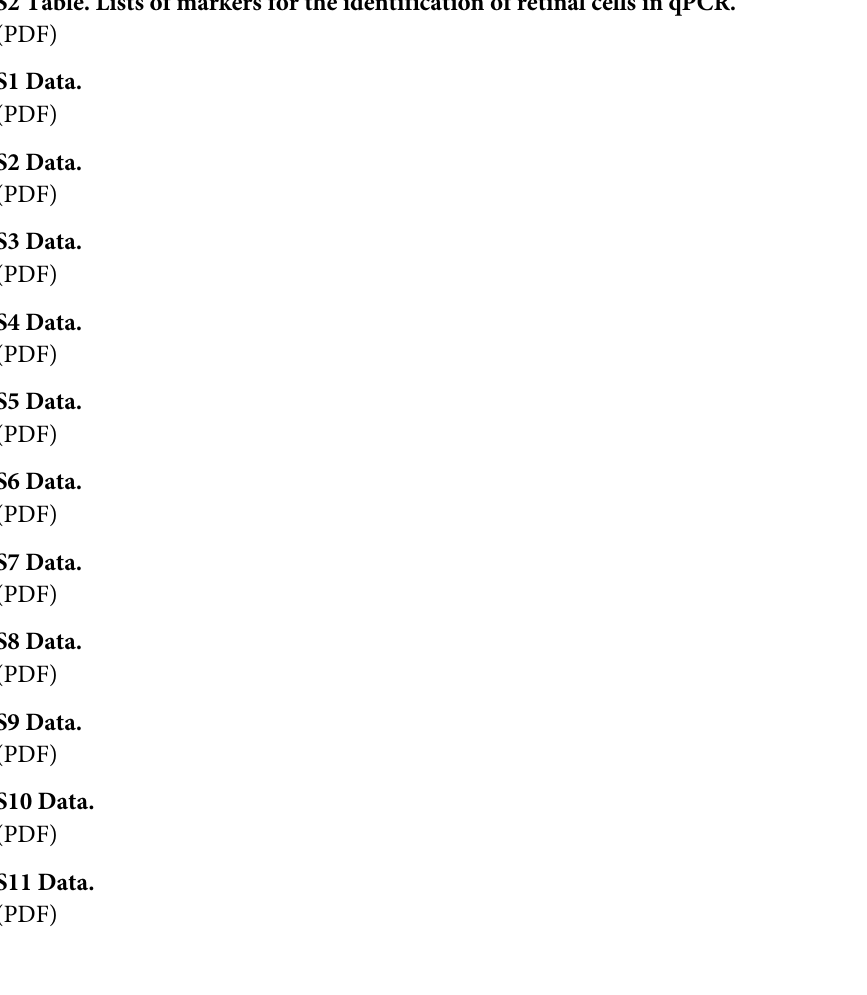
S9 Fig. Persistence of Rho expression after discontinuation of SLCD treatment. A) Time course of the experiments using GFAP-td-Tomato. After an administration of 75 mg/kg MNU, intravitreal injection of SLCD was performed at day 0, 3 and 6. B) Immunohistochemis- try of Rho (white) and DAPI (blue) after intravitreal injection of SLCD on days 7, 10, and 13 after MNU administration. (n = 5). Scale bar = 100 μ m. S10 Fig. Effects of SLCD on expression of the neural markers, other than Rho in rd10 mice. Real-time qPCR results of the retinal cell-specific markers in the whole retina on day 7 and 14 after the intravitreal injection of SLCD (n = 5). All data are presented as the mean ± SEM. S1 Table. Primer sequences. (PDF) S2 Table. Lists of markers for the identification of retinal cells in